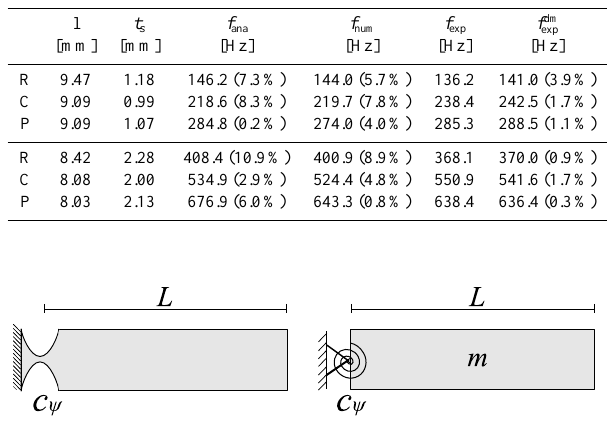
Table 4. Overall center of rotation for rectangular (R), circular (C) and parabolic (P) flexure hinges.